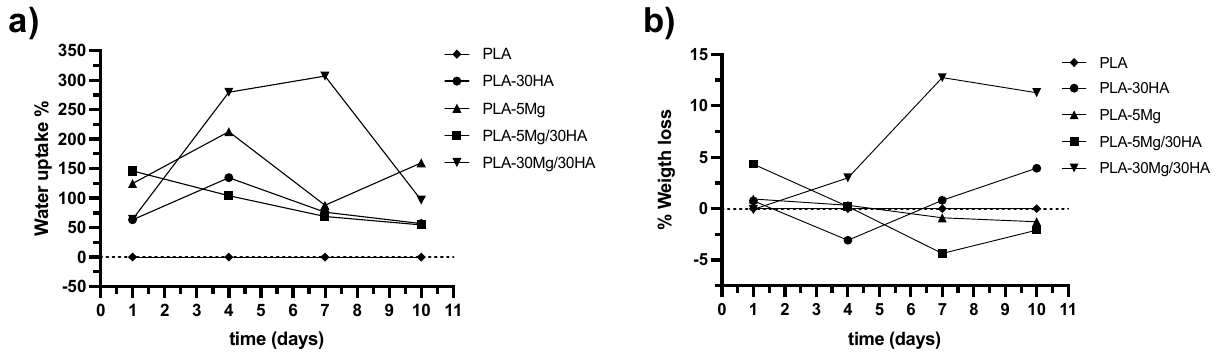
Figure 3. ( a ) Water uptake evolution and ( b ) weight loss trend. Data were obtained at different immersion times in PBS. Tested samples were PLA; mono-biophase composites PLA-30 HA and PLA-5 Mg; bi-phases composites PLA-5 Mg/30 HA and PLA-30 Mg/30 HA. A continuous weight loss trend is evident for PLA-5 Mg and PLA-5 Mg/30